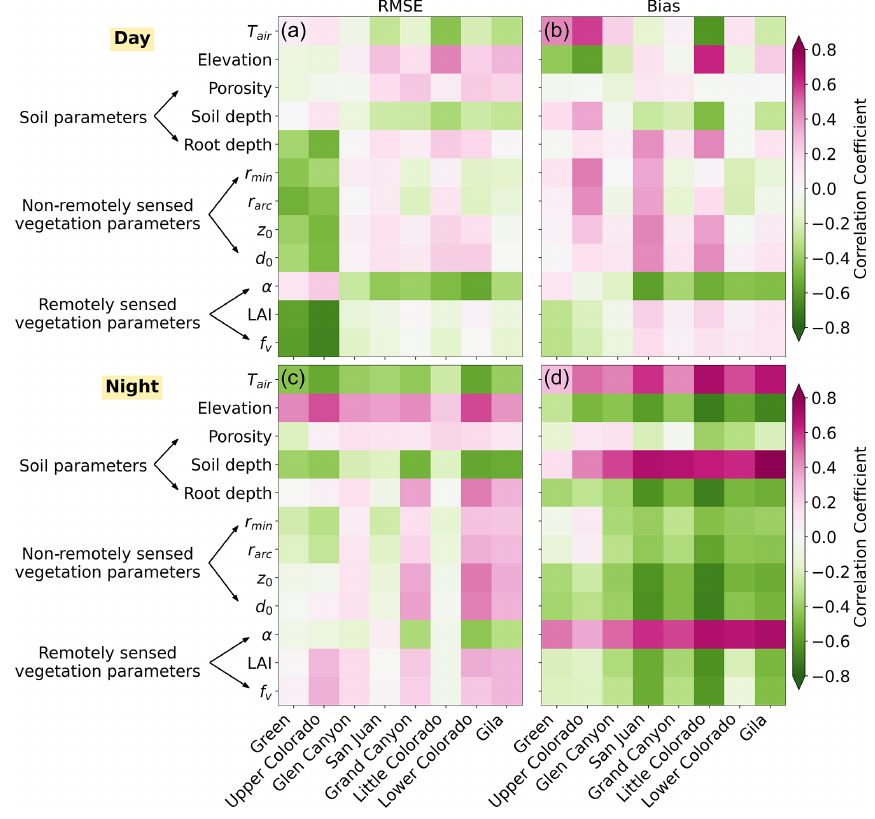
Figure 7. Heatmaps showing the Pearson correlation coefficient between (1) the spatial map of T air or key soil and vegetation parameters involved in the energy balance and (2) the spatial map of the error metrics – (a, c) RMSE and (b, d) bias – between the time series of LST M and LST V for the baseline simulation. The correlation coefficients are computed for each subbasin. Symbols are explained in Table 2. Top (bottom) row is for daytime (nighttime)